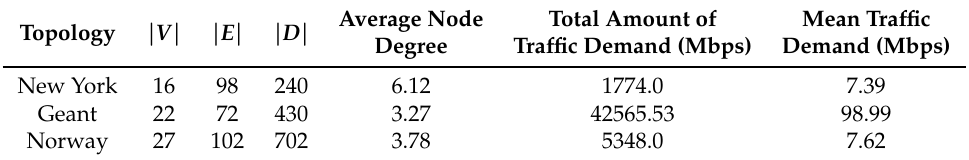
Table 2. Main characteristics of considered